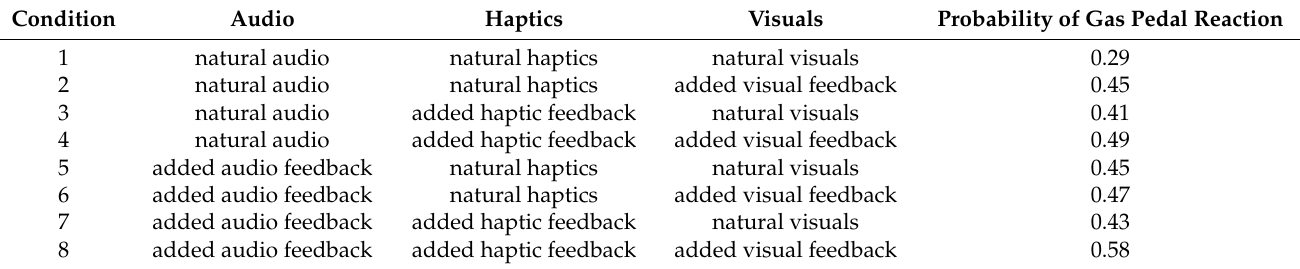
Table 3. Model predictions for each condition (without participant-level random